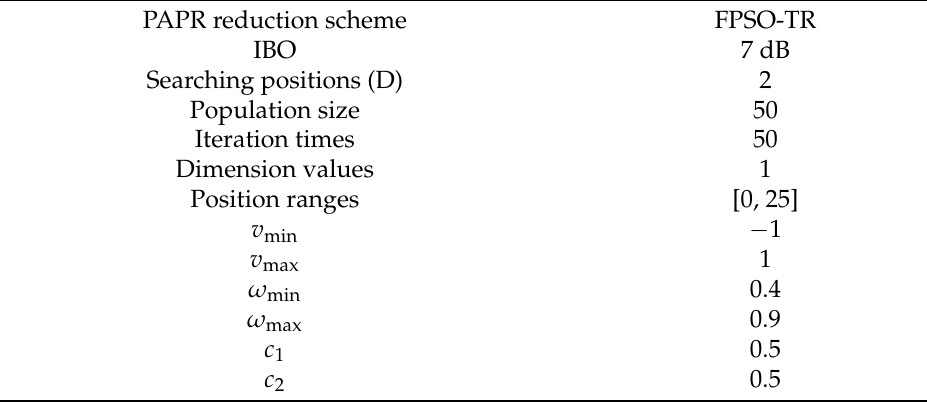
Table 2. FPSO-TR parameters setting.